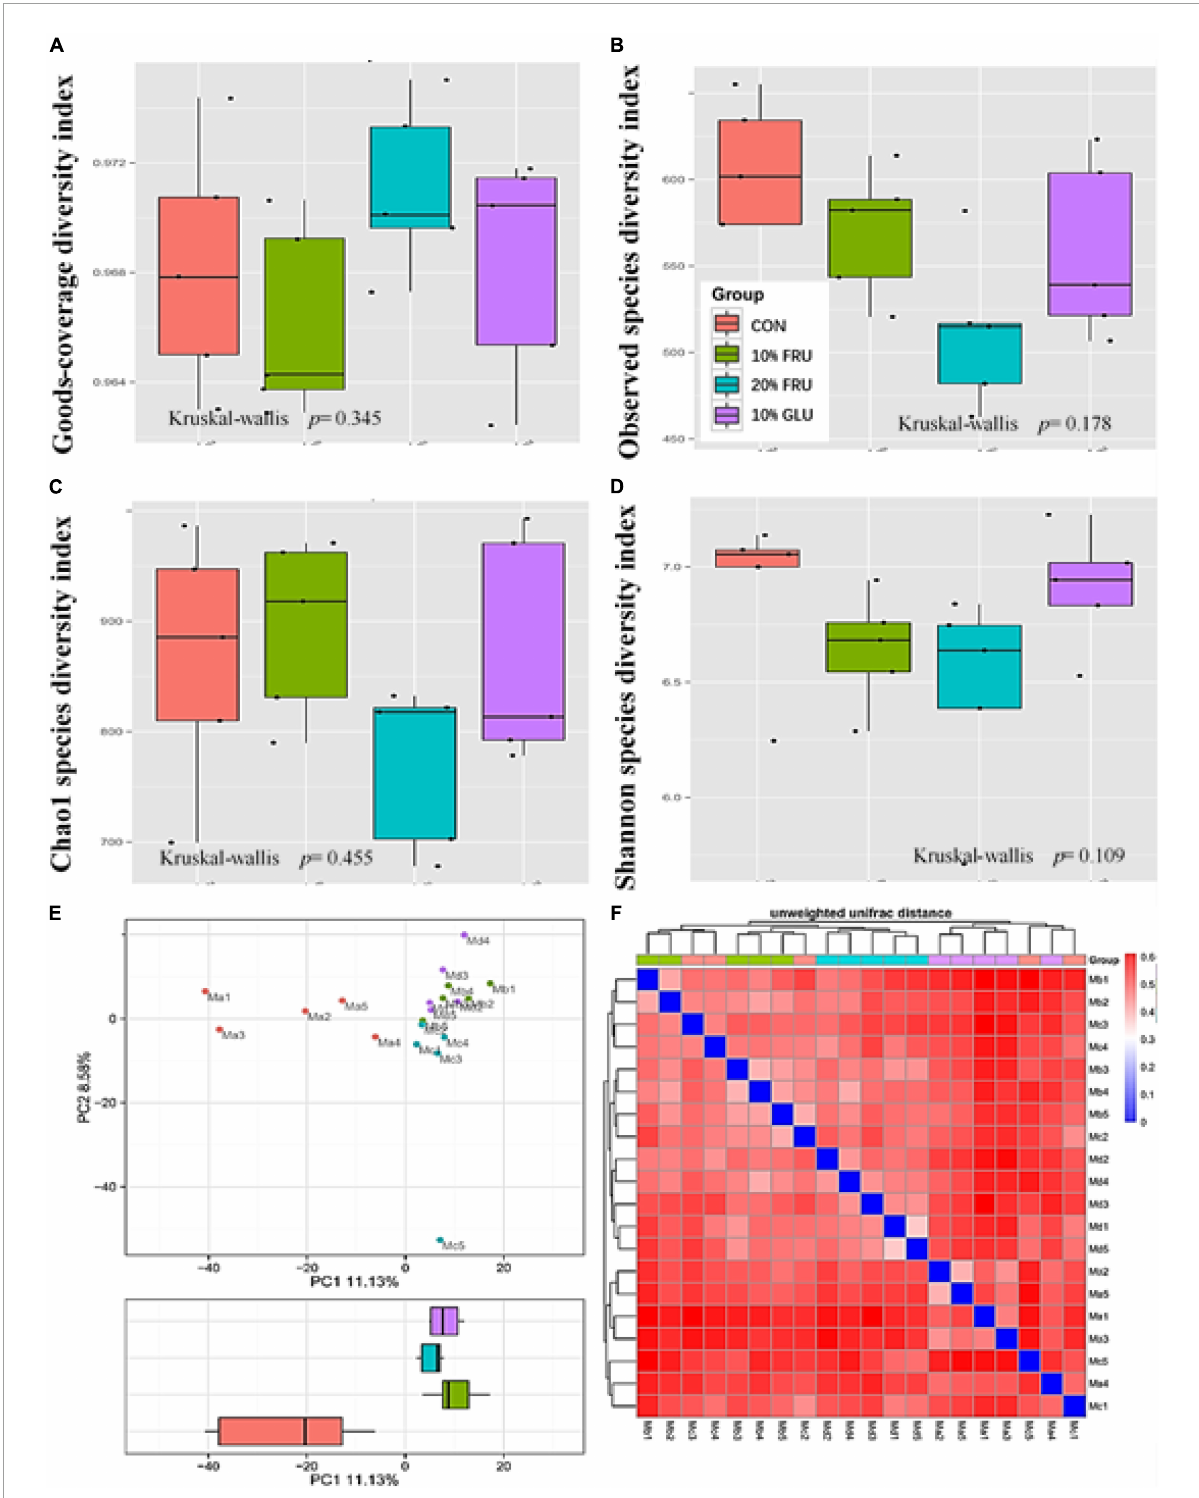
FIGURE3 Responses of the diversity, richness, and structure of the gut microbiota to fructose treatment in rats: (A) goods-coverage diversity index, (B) observed species diversity index, (C) Chao1 index, (D) Shannon index, (E) principal component analysis (PCA) score plot based on weights, and (F) unweighted UniFrac distance. Values were presented as mean ± SEM ( n = 5). Ma or red color represented the CON group, Mb or green color represented the 10% FRU group, Mc or blue color represented the 20% FRU group, and Md or purple color represented the 10% GLU